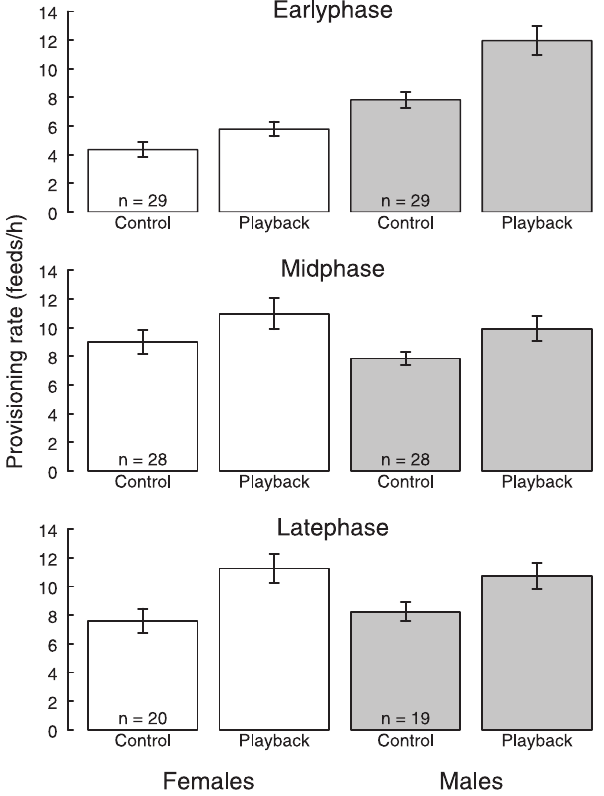
Figure 2. The mean feeding rate of focal females (white bars) and males (grey bars) during the control period and exper- imental period at all nestling stages. Values are from the raw data. Sample size and SE are indicated.